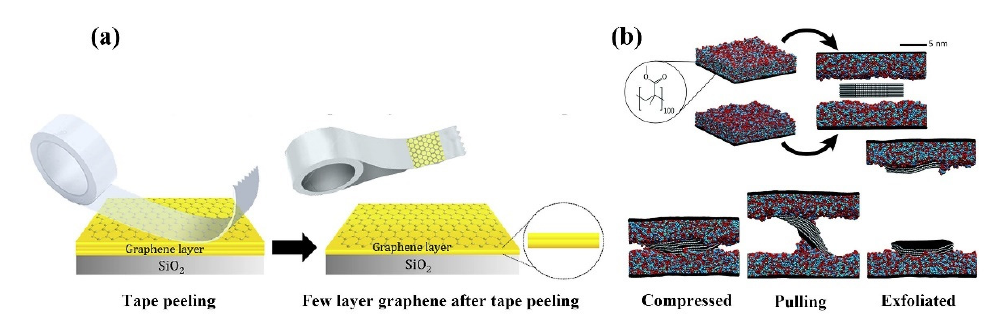
Figure 1. ( a ) Schematic diagram of graphene preparation on SiO 2 using tape-peeling method. Reprinted with permission from Ref. [45]. Copyright 2020, Elsevier. ( b ) Schematic diagram of graphene exfoliation using polymeric tape. Graphite is first compressed between two polymer layers, and then the interval between the polymer layers is increased to exfoliate the graphite to prepare graphene. Reprinted with permission from Ref. [46]. Copyright 2019, Royal Society of Chemistry.